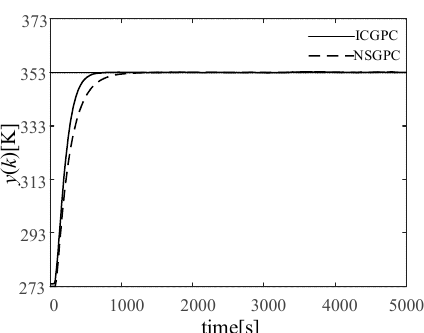
Figure 6. Output curve of constrained generalized predictive control. ICGPC: input softening factor to design constrained generalized predictive control; NSGPC: the nonlinear separation method generalized predictive control.